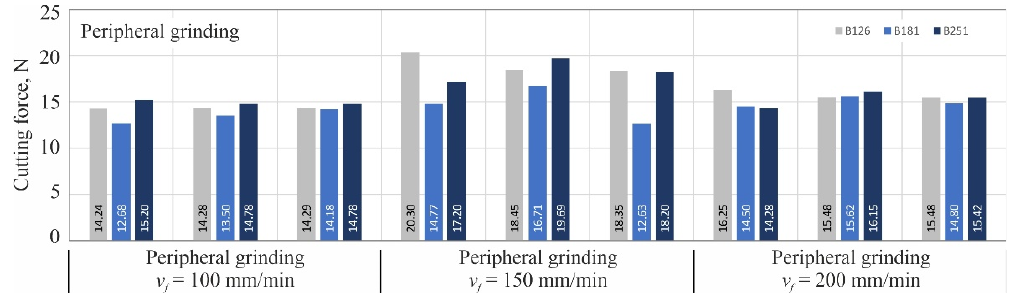
Figure 5. Results of cutting force measurements of blades shaped by peripheral grinding with cBN abrasive grains B126, B181 and B251 at feed rates v f of 100; 150; 200 mm/min.